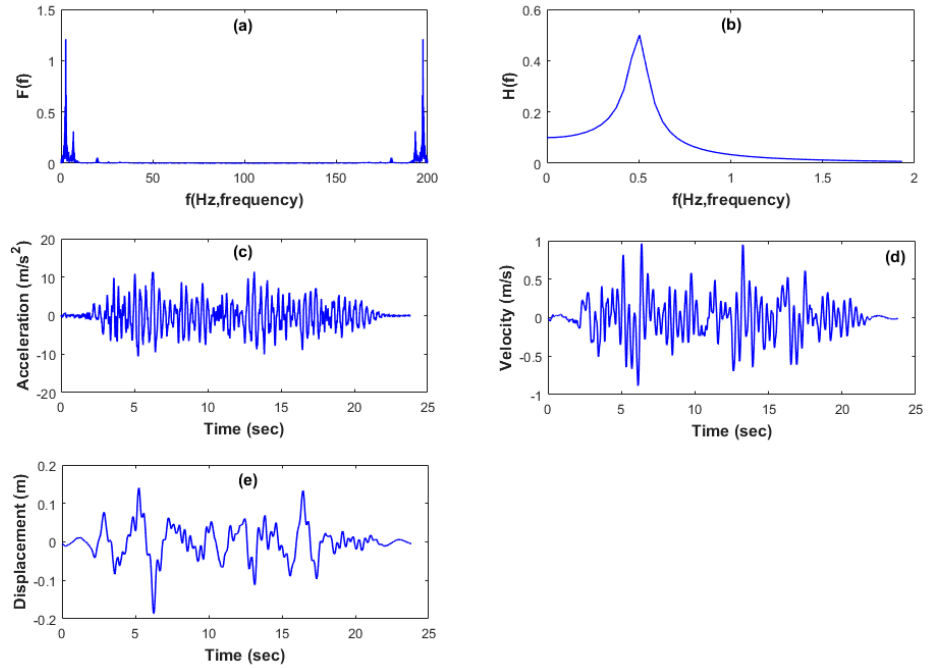
and ( e ) displacement.